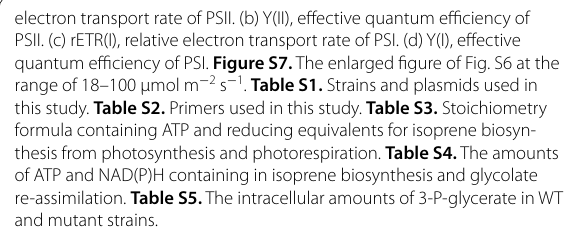
quantum efficiency of PSI. Figure S7. The enlarged figure of Fig. S6 at the range of 18–100 μmol m − 2 s − 1 . Table S1. Strains and plasmids used in this study. Table S2. Primers used in this study. Table S3. Stoichiometry formula containing ATP and reducing equivalents for isoprene biosyn- thesis from photosynthesis and photorespiration. Table S4. The amounts of ATP and NAD(P)H containing in isoprene biosynthesis and glycolate re-assimilation. Table S5. The intracellular amounts of 3-P-glycerate in WT and mutant